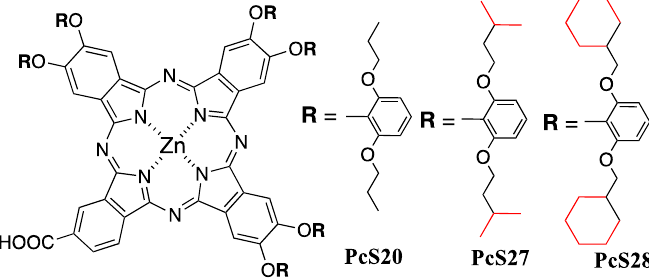
Figure 2. Structure of phthalocyanine sensitizers PcS20 , PcS27 , and PcS28 . Red: structural differences with PcS20 .